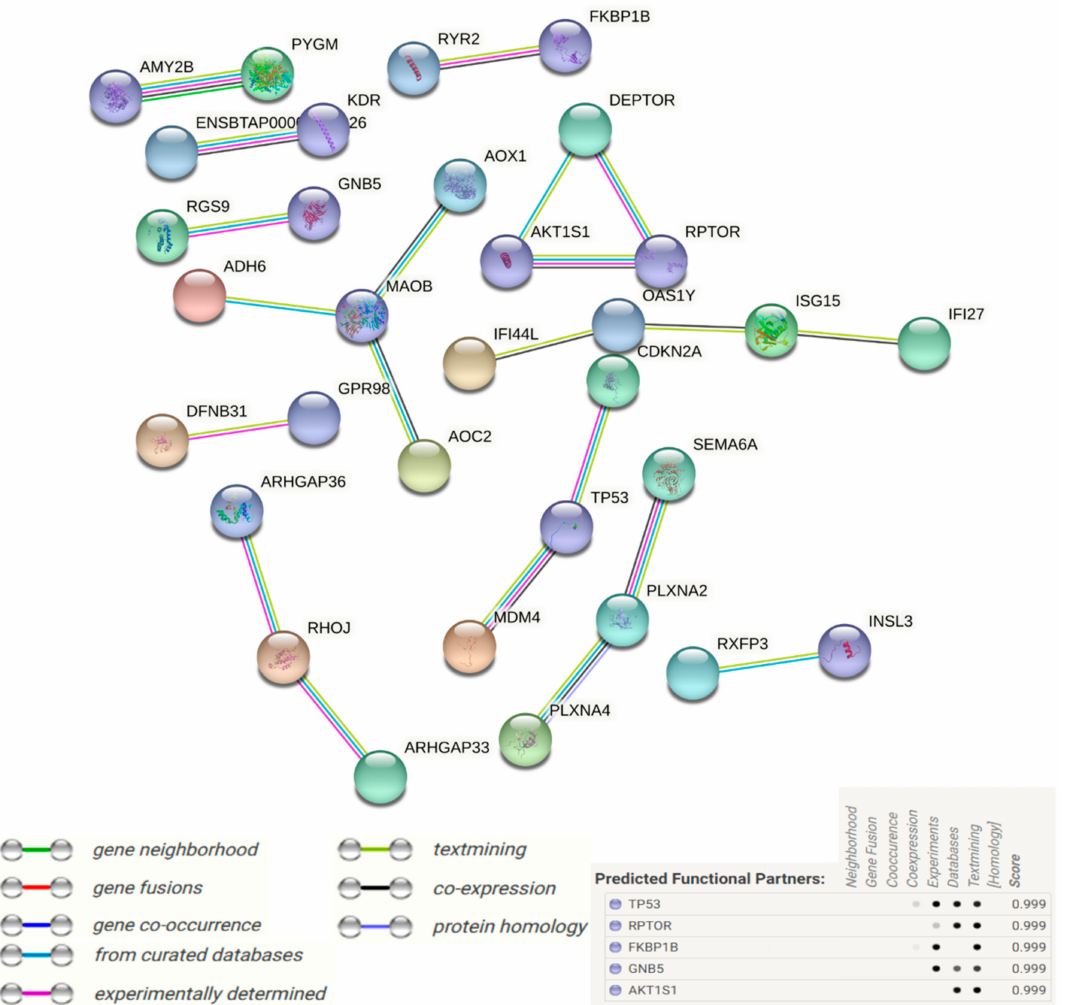
Figure 9. STRING interaction analysis of all differentially expressed genes in control verses heat- stressed granulosa cells. Interaction was performed with a confidence score of 0.9. Nodes represent genes and lines between nodes refer to edges showing various sorts of interactions denoted by different colors and defined through the legends present in the figure; standalone nodes lacking edges were removed. Important nodes with the highest interaction scores of functional predictions are given in the bottom right of the